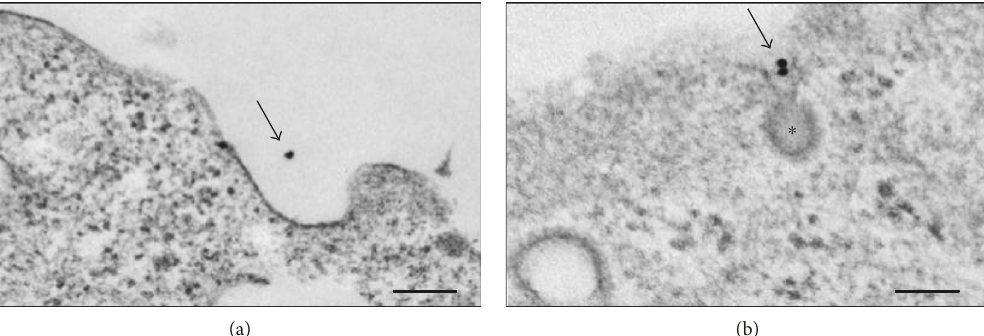
Figure 1: Endocytosis of colloidal gold-mannose bovine serum albumin (ManBSA) via clathrin-coated pits in 16HBEC. (a) Gold-BSA; (b) gold-ManBSA. ∗ Clathrin-coated pit. Arrows: gold particles. Electron microscopy scale bar: 100 nm.